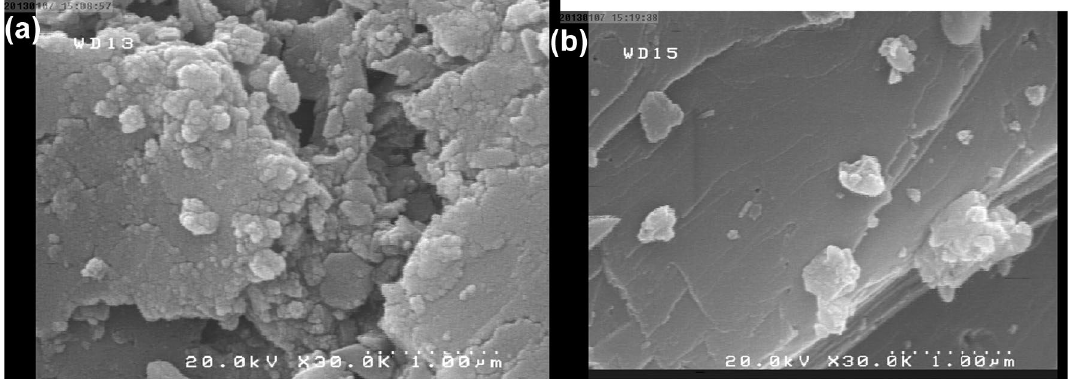
Fig. 11 SEM image of mud cake surface morphology after filtration test, a drilling fluid without core–shell nanocomposite, b drilling fluid +3gr core–shell nanocomposite